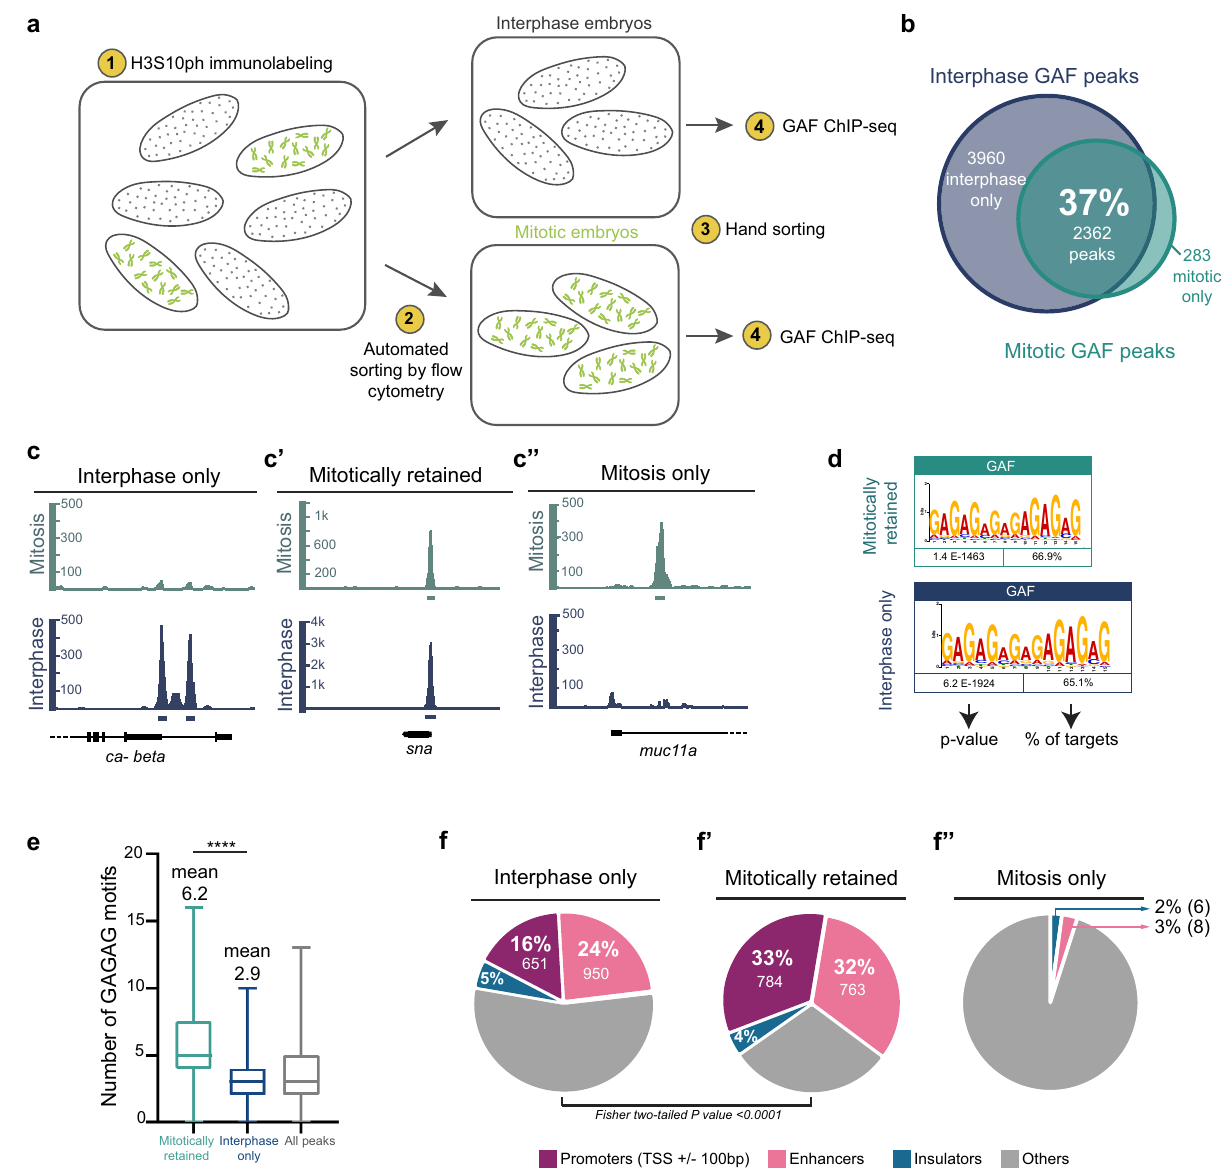
Fig. 2 Identi fi cation of thousands of mitotically retained GAF loci. a Experimental work fl ow of mitotic embryo sorting followed by GAF-ChIP-seq. Embryos are immunolabeled with anti-H3S10ph (1), then sorted using a fl ow cytometer (2). Two pools of embryos are obtained (mitotic and interphase embryos) and are then hand-sorted (3) to remove any contamination. GAF-ChIP sequencing is then performed on approximately 1000 embryos of each condition (4). b Venn diagram representing the overlap of called GAF-ChIP-seq peaks between interphase and mitotic embryos. c , c ’ , c ” Genome browser examples of genes from the identi fi ed three categories of GAF-ChIP-seq peaks: interphase only, mitotically retained, and mitosis only, respectively. Rectangles represent the called peaks corresponding to the above pro fi le. d (GA) n motif enrichment within GAF mitotically retained and interphase-only peaks, as reported by MEME. e Box plot representing the number of GAGAG motifs within three different classes of GAF peaks: mitotically retained (light blue) n = 2362, interphase only (dark blue) n = 3960, and all peaks (gray) n = 283. The centered horizontal line represents the median; whiskers represent min and max values. Two-tailed Welch ’ s t test **** P < 0.0001. f , f ’ , f ” Proportions of GAF-ChIP-seq peaks that overlap diverse cis -regulatory regions in interphase only, mitotically retained and mitosis-only